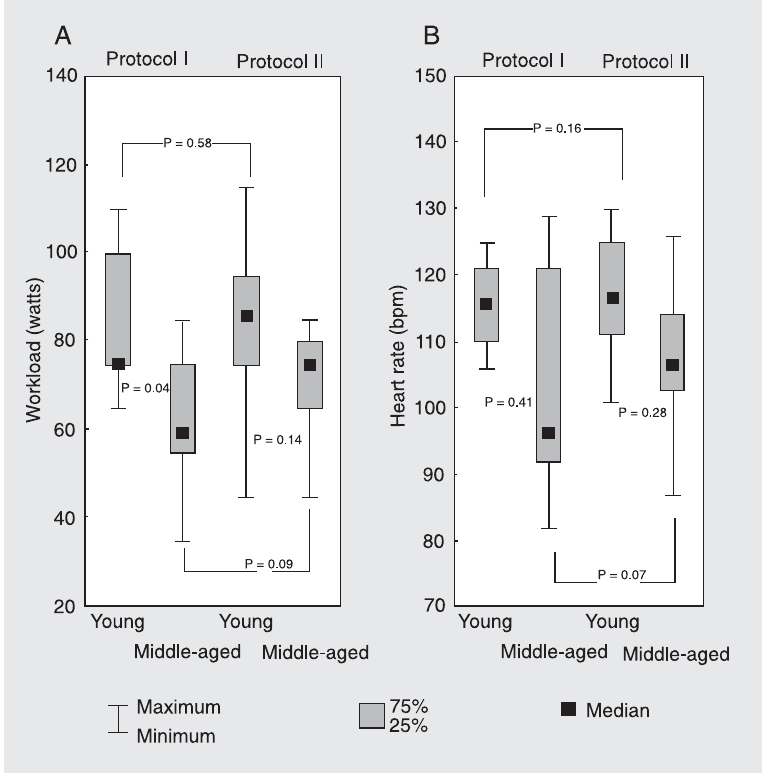
Figure 1. A , Workload values, and B , heart rate at which the assumed anaerobic threshold (AT) of the young and middle-aged volunteer groups, respectively, occurred during a discontinuous dynamic exercise test (protocols I and II). α =